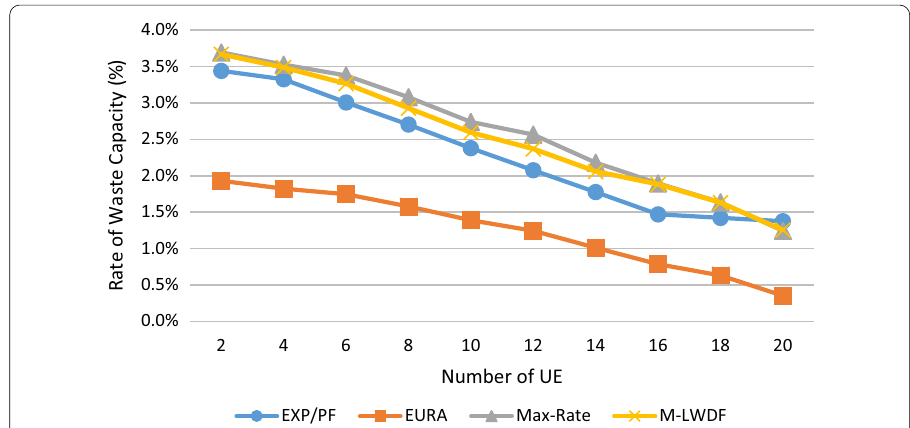
Fig. 12 Simulation result of waste capacity rate; The performance comparison of waste capacity rate for our proposed scheme and the contrasts